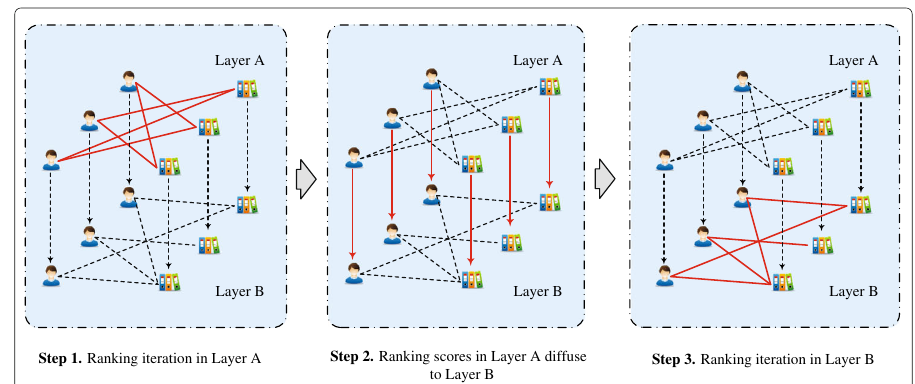
Fig. 1 M-BiRank framework. M-BiRank contains three iterative